Question: Express in one sentence what the figure is showing.
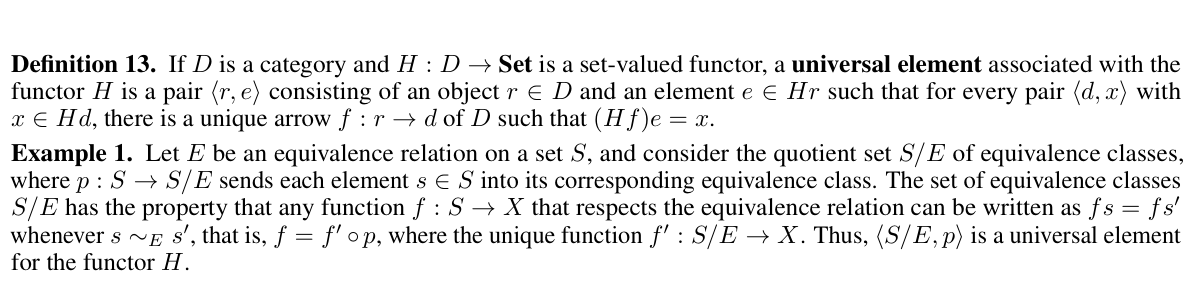
Answer: illustrates the concept of universal arrows through the connection between categories and graphs. For every (directed) graph G, there is a universal arrow from G to the “forgetful” functor U mapping the category Cat of all categories to Graph, the category of all (directed) graphs, where for any category C, its associated graph is defined by U(C). Intuitively, this forgetful functor “throws” away all categorical information, obliterating for example the distinction between the primitive morphisms f and g vs. their compositions g ◦f, both of which are simply viewed as edges in the graph U(C). To understand this functor, consider a directed graph U(C) defined from a category C, forgetting the rule for composition. That is, from the category C, which associates to each pair of composable arrows f and g, the composed arrow g ◦f, we derive the underlying graph U(C) simply by forgetting which edges correspond to elementary arrows, such as f or g, and which are composites. For examp